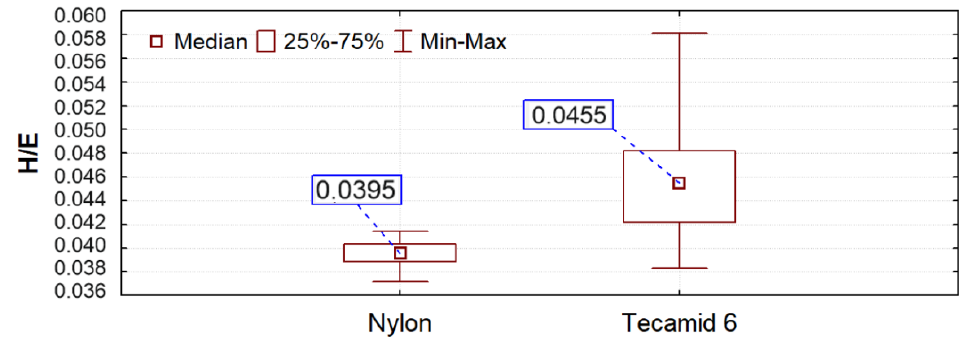
Figure 11. Box plot of H/E ratio calculation